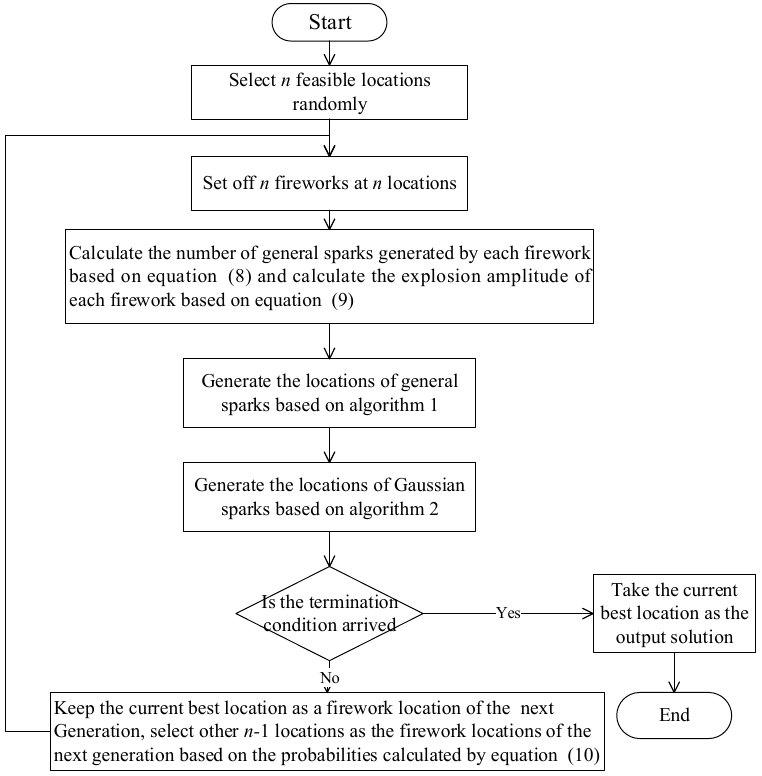
Figure 2. The flow chart of the Fireworks Algorithm (FWA).